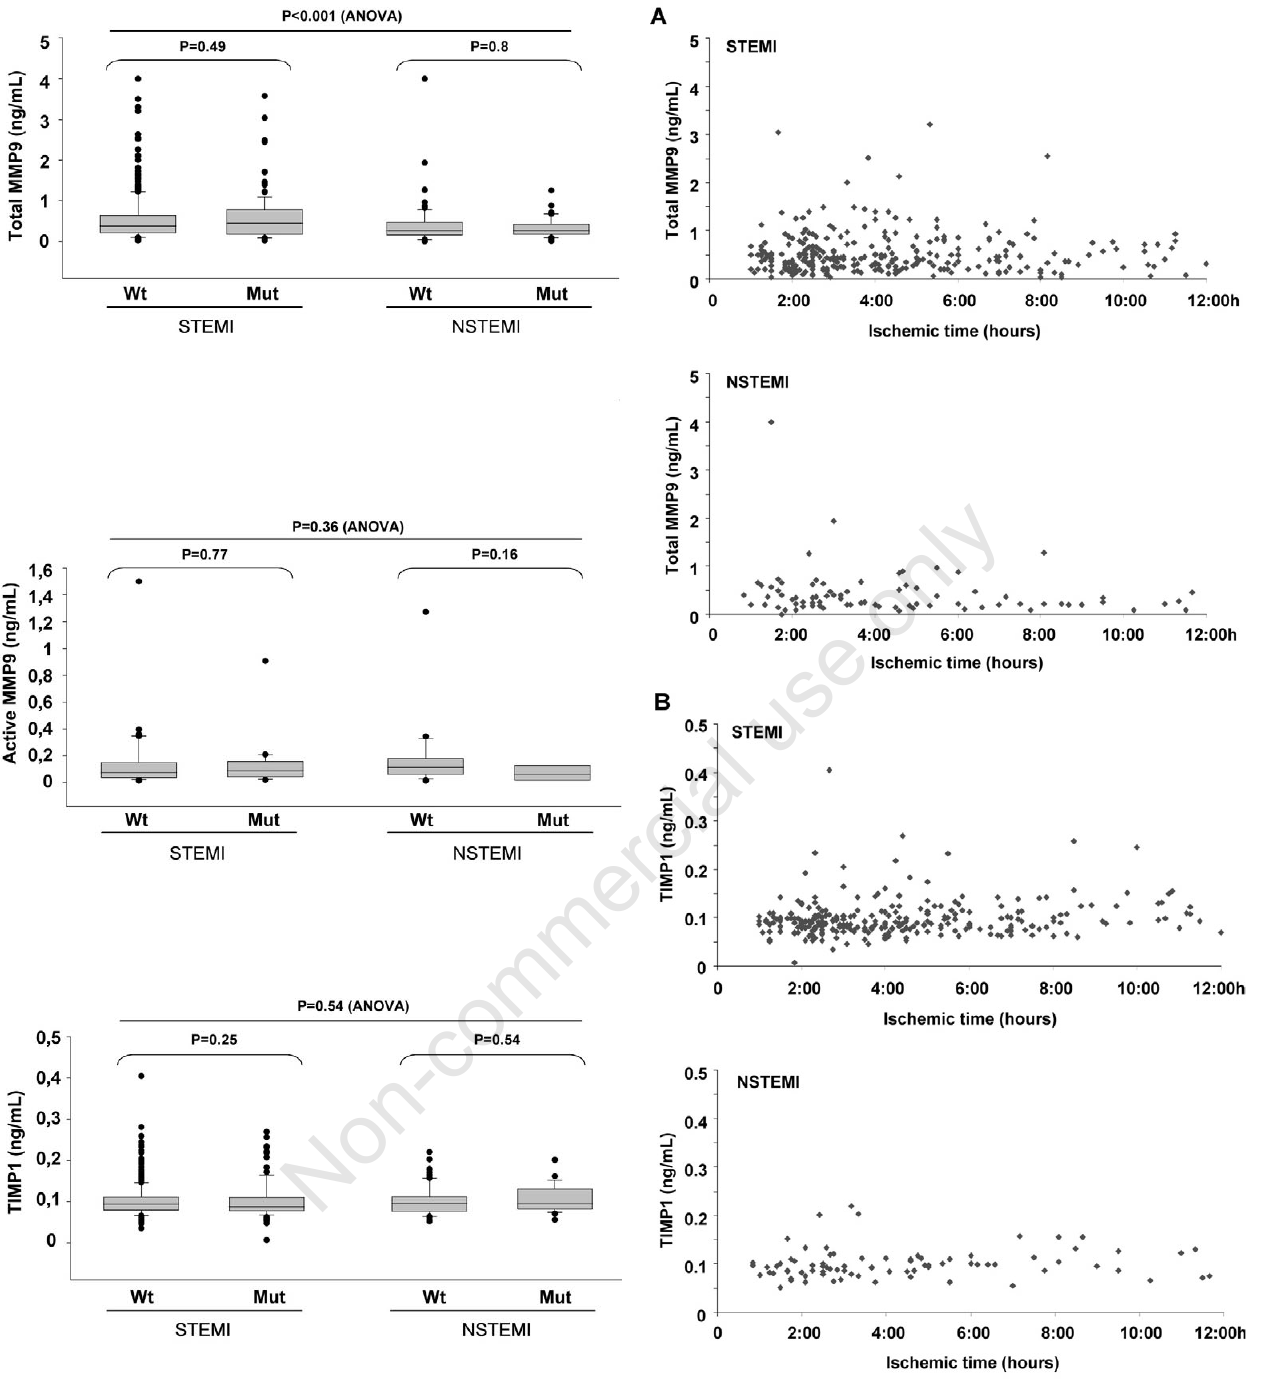
Figure 6. Plasma levels of total MMP9 and TIMP1 according to the delay between chest pain onset and blood sampling ( Ischemic time ) in MI patients. Total MMP9 (A) and TIMP1 (B) plasma level during the 12 hours following acute